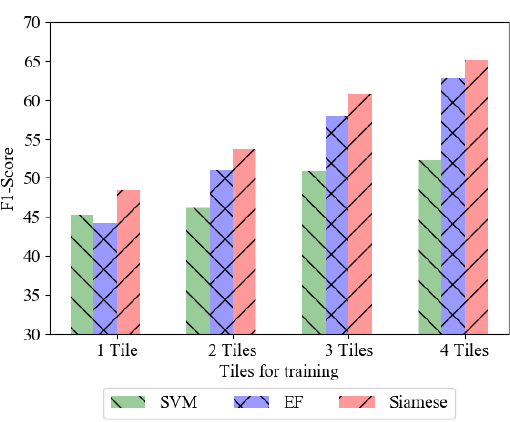
Figure 5. F1-Score from each method using 1, 2, 3 and 4 Tiles for training.